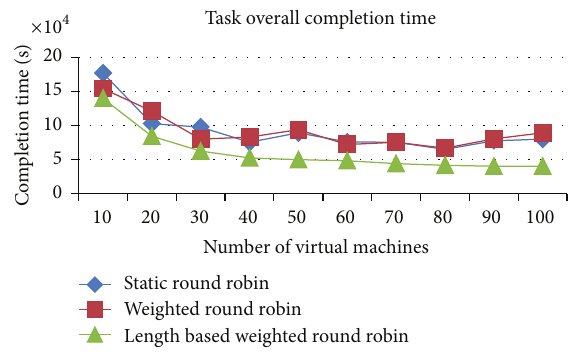
Figure 4: Execution completion time (space shared).